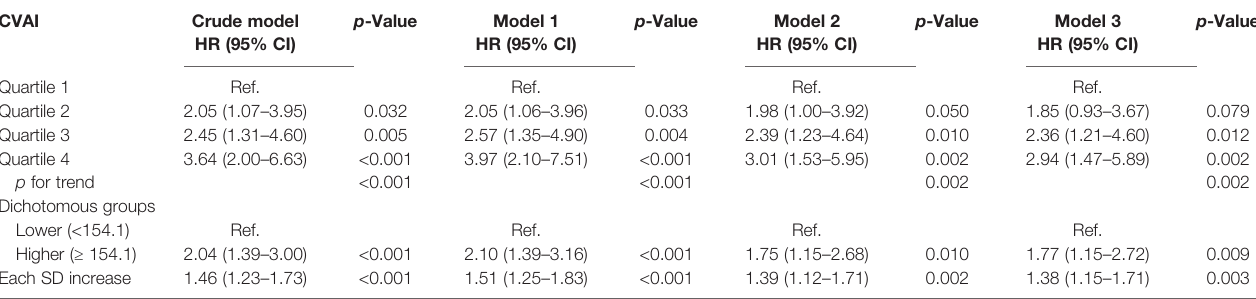
TABLE 3 | Multivariable Cox regression for the association between CVAI and incident overt renal damage.